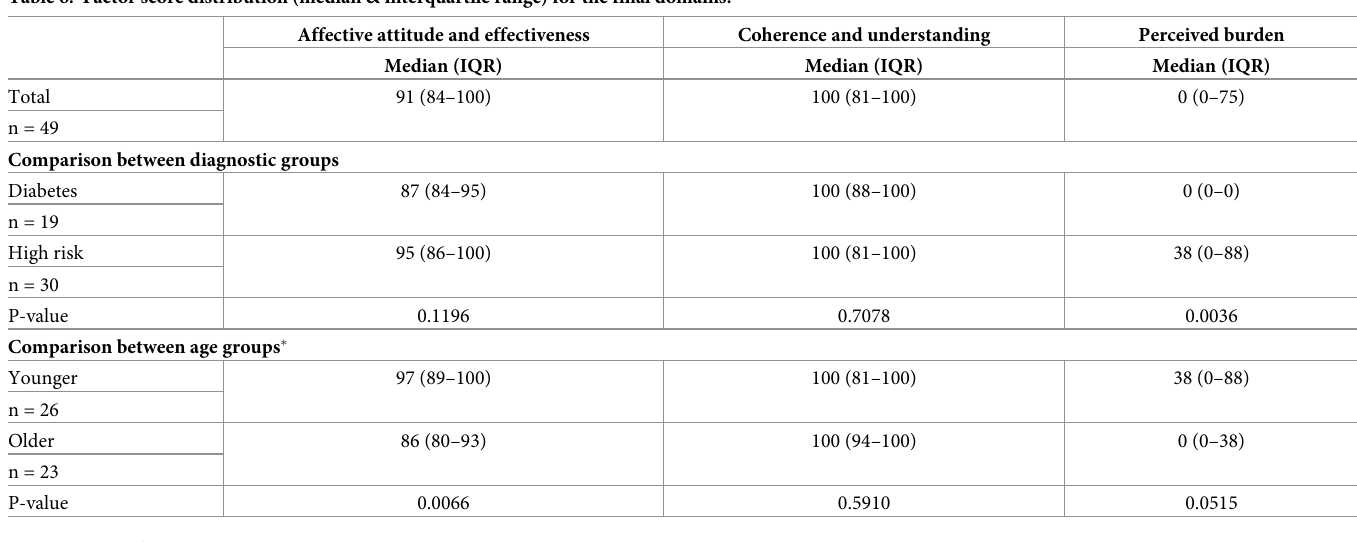
Table 6. Factor score distribution (median & interquartile range) for the final